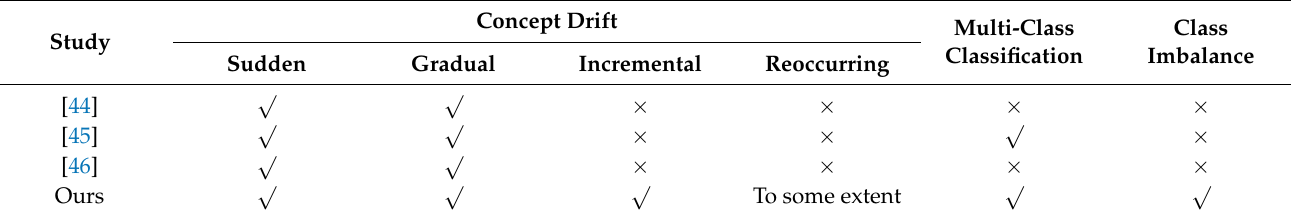
Table 1. Comparative studies on drift detection